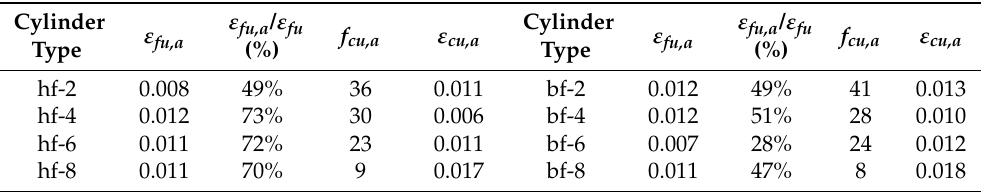
Table 4. Recorded maximum spiral strains in different concrete